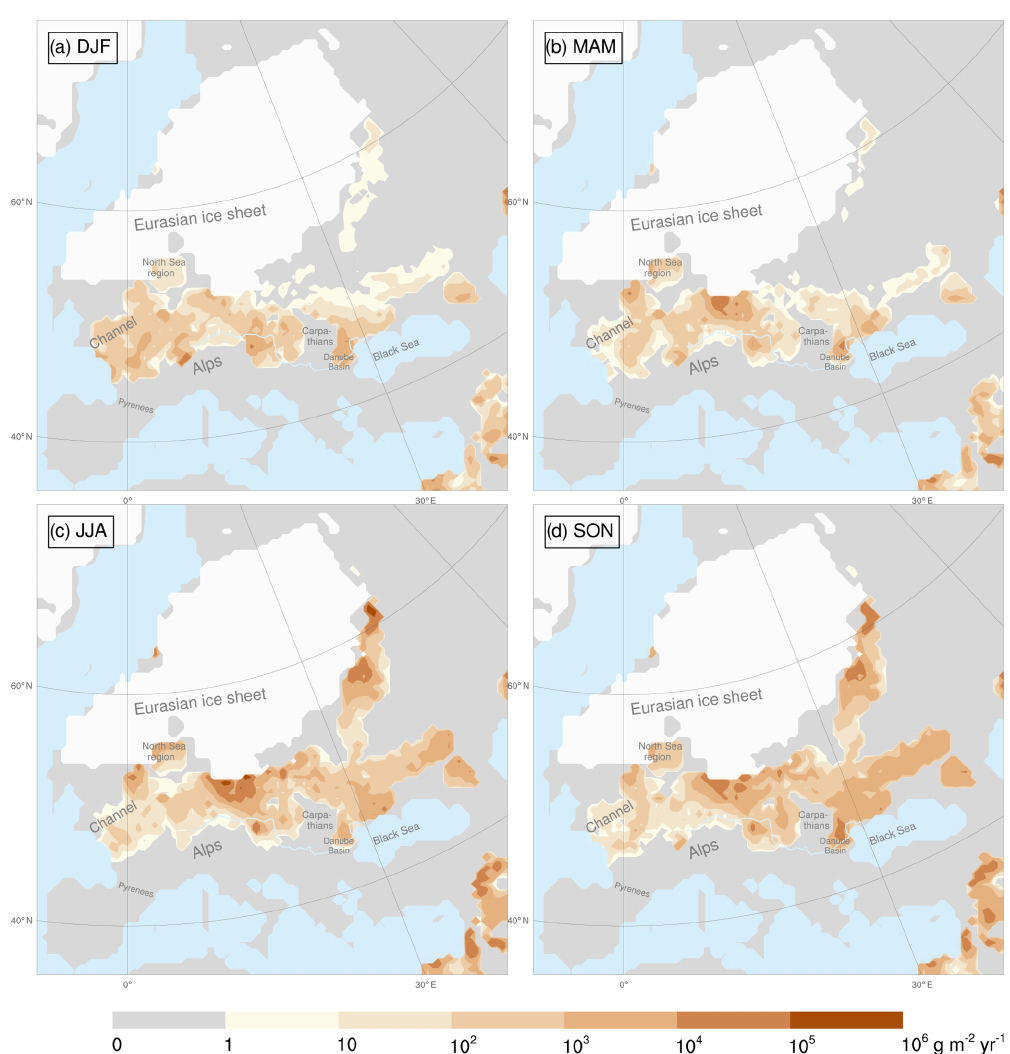
Figure 5. Dust emission rates for (a) winter (DJF), (b) spring (MAM), (c) summer (JJA), and (d) autumn (SON) during the Last Glacial Maximum. This reconstruction is based on dynamic downscaling. The Danube (light-blue line) and the extent of the continental ice sheets (white) are